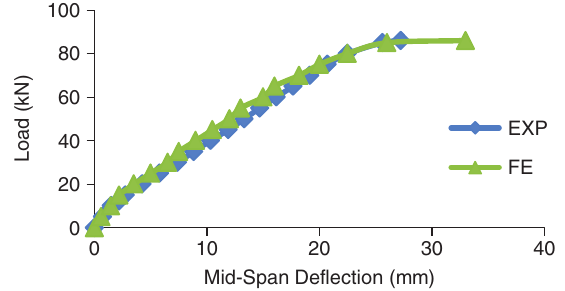
Fig. 23. Load against cumulative de fl ection curves for the repair cycle loading of the beam G4R3